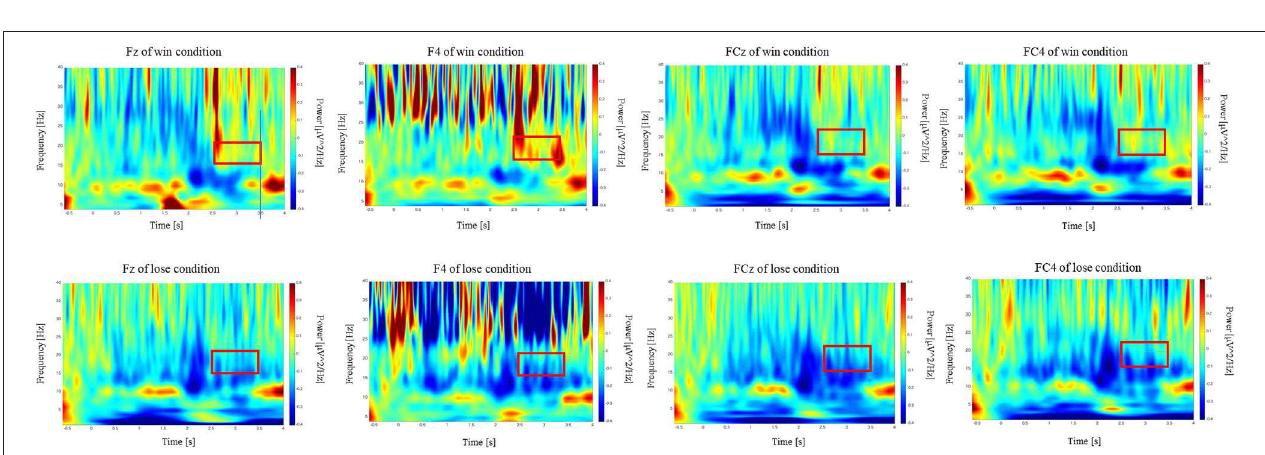
FIGURE 3 | Change in power at the C3 electrode while participants watched the RPS game in the AO session. (A) Scalogram showing power at the C3 electrode while participants watched the RPS game in the AO session. (B) We observed significant power suppression at 8–14Hz after the player began swinging their hand [ t (15) = 2.79, p < 0.05].